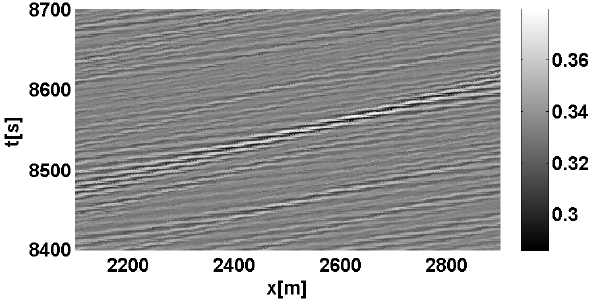
Fig. 20. The density plot of the variance of the total wave phase for IW9.